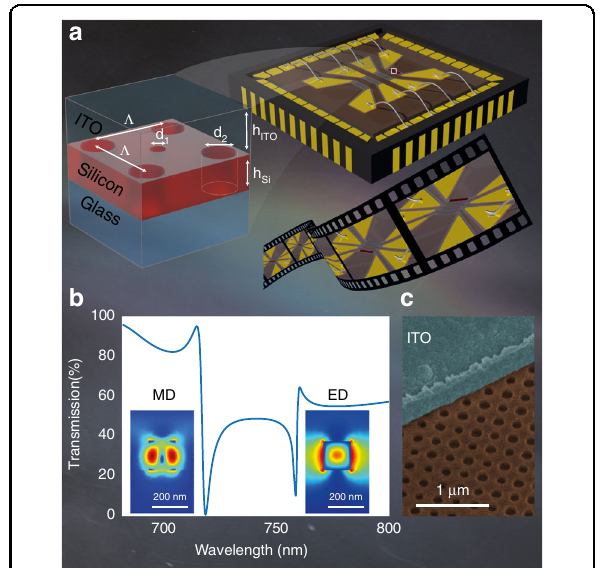
Fig. 1 Electrically switchable metasurface pixels by fl ash localised heating. a Illustration of the fabricated sample, composed of designed nanoholes in a silicon fi lm, so-called hole array metasurfaces, embedded in an ITO transparent heater. The pixel ’ s optical responses are switched by applying a voltage across the contacts, which locally heats the metasurfaces. The thermo-optical effect results in an alteration of the metasurface scattering properties. b The calculated transmission spectra of hole-array metasurfaces together with the normalised electric fi eld pro fi les (|E|) at both resonances. The parameters of the design are his = 155 nm, d 1 = 78 nm , d 2 = 101 nm, h ITO = 380 nm, and pitch Λ = 350 nm. c Coloured SEM image of